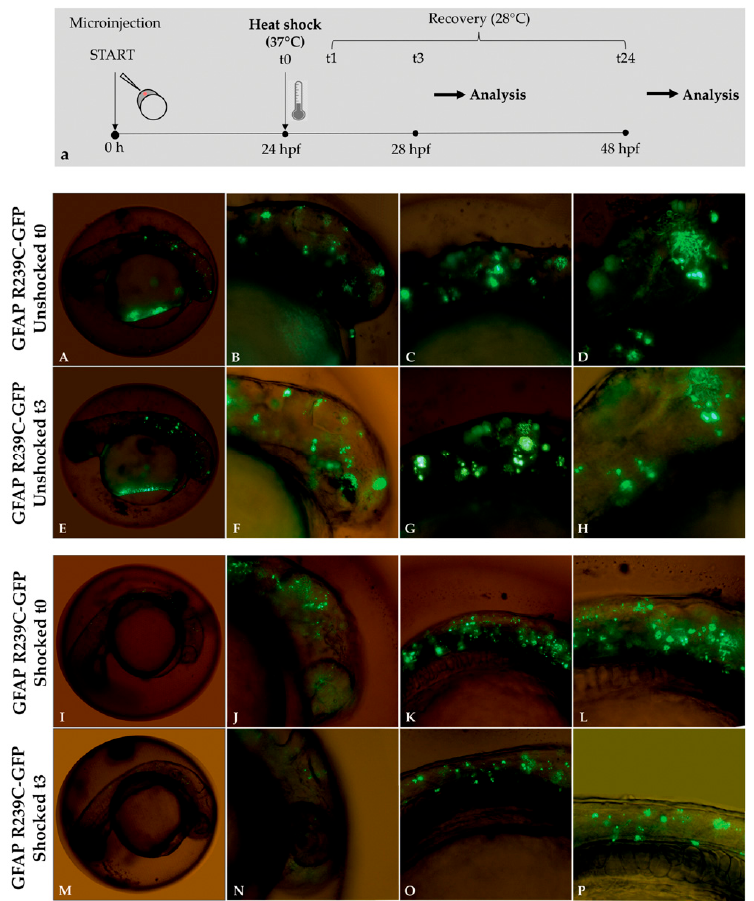
Figure 9. Experimental plan showing the timeline of heat-shock treatments and e ff ects of thermal shock on p.R239C aggregates. ( a ) At 24 hpf, embryos were incubated for 1 h at 37 ◦ C and then recovered at 28 ◦ C. Fluorescence microscope analysis was performed after 3 (t3) and 24 h (t24) from the end of